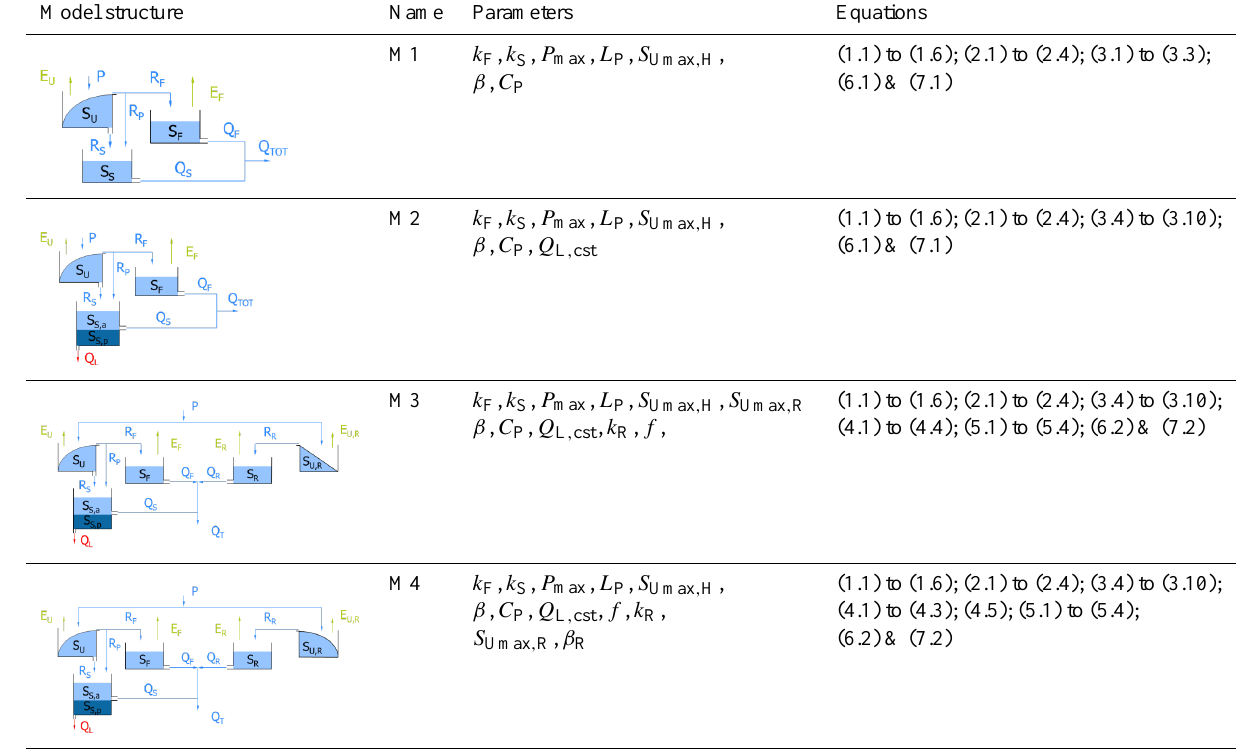
Table 2. Model structures and parameters.